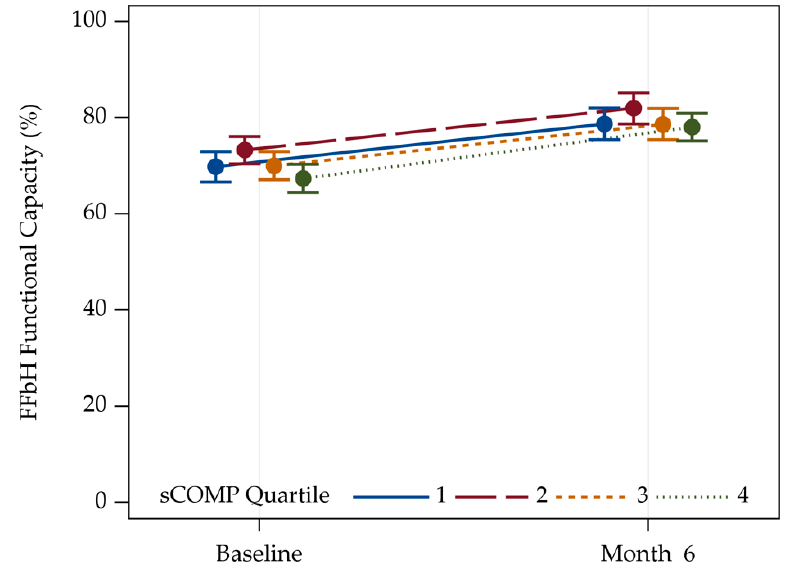
Figure 1. Trajectories of the FFbH Hannover Functionality Status of patients with knee OA. Values are given as means with two-sided 95% confidence limits. sCOMP Quartile 1: N = 79, Quartile 2: N = 85, Quartile 3: N = 88, Quartile 4: N = 108.